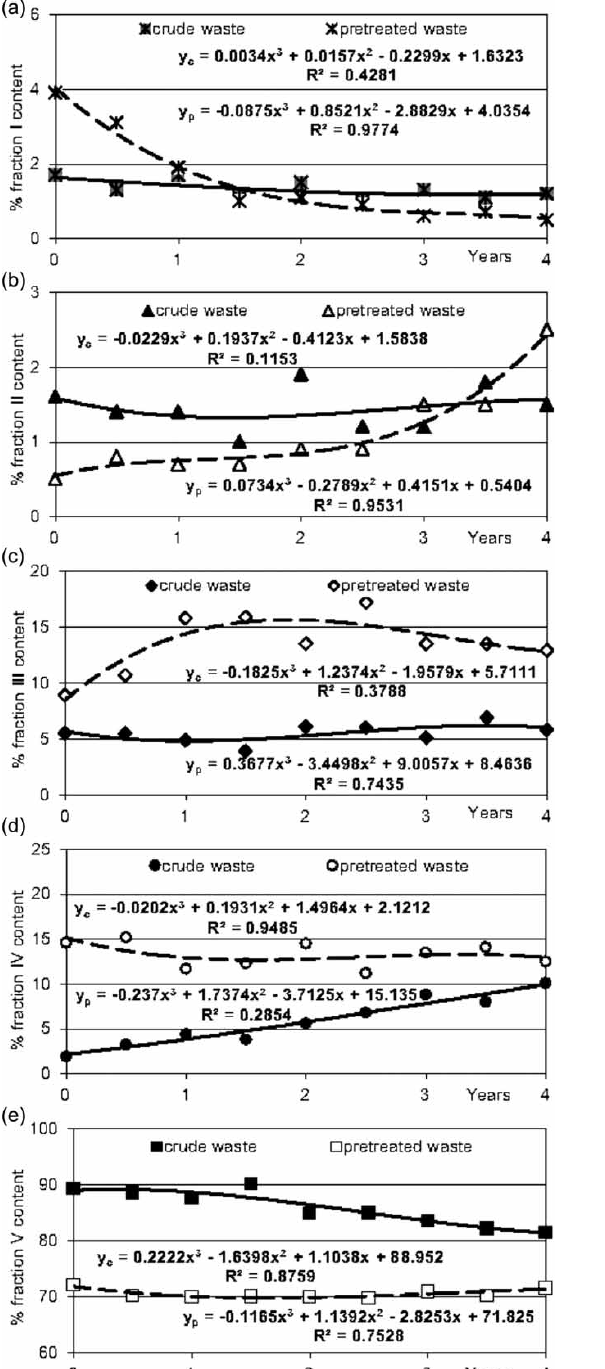
Fig. 5. Changes in the fractional content of copper (Cu) in the surface layer of soil from the experimental plots irrigated and fertilized with mixed wastewaters from an oleo-chemical factory (cid:1) defatted raw (solid line of the trend (cid:1) y c ) and pretreated (broken line of the trend (cid:1) y p ) (C 0(Cu) (cid:1) 11.6 9 0.8 mg/kg d.m.). Individual fractions are given in diagrams: (a) fraction I (cid:1) exchanged, (b) fraction II (cid:1) carbonate, (c) fraction III (cid:1) connected with hydrated oxides of manganese and iron, (d) fraction IV (cid:1) organic, (e) fraction V (cid:1) the residual